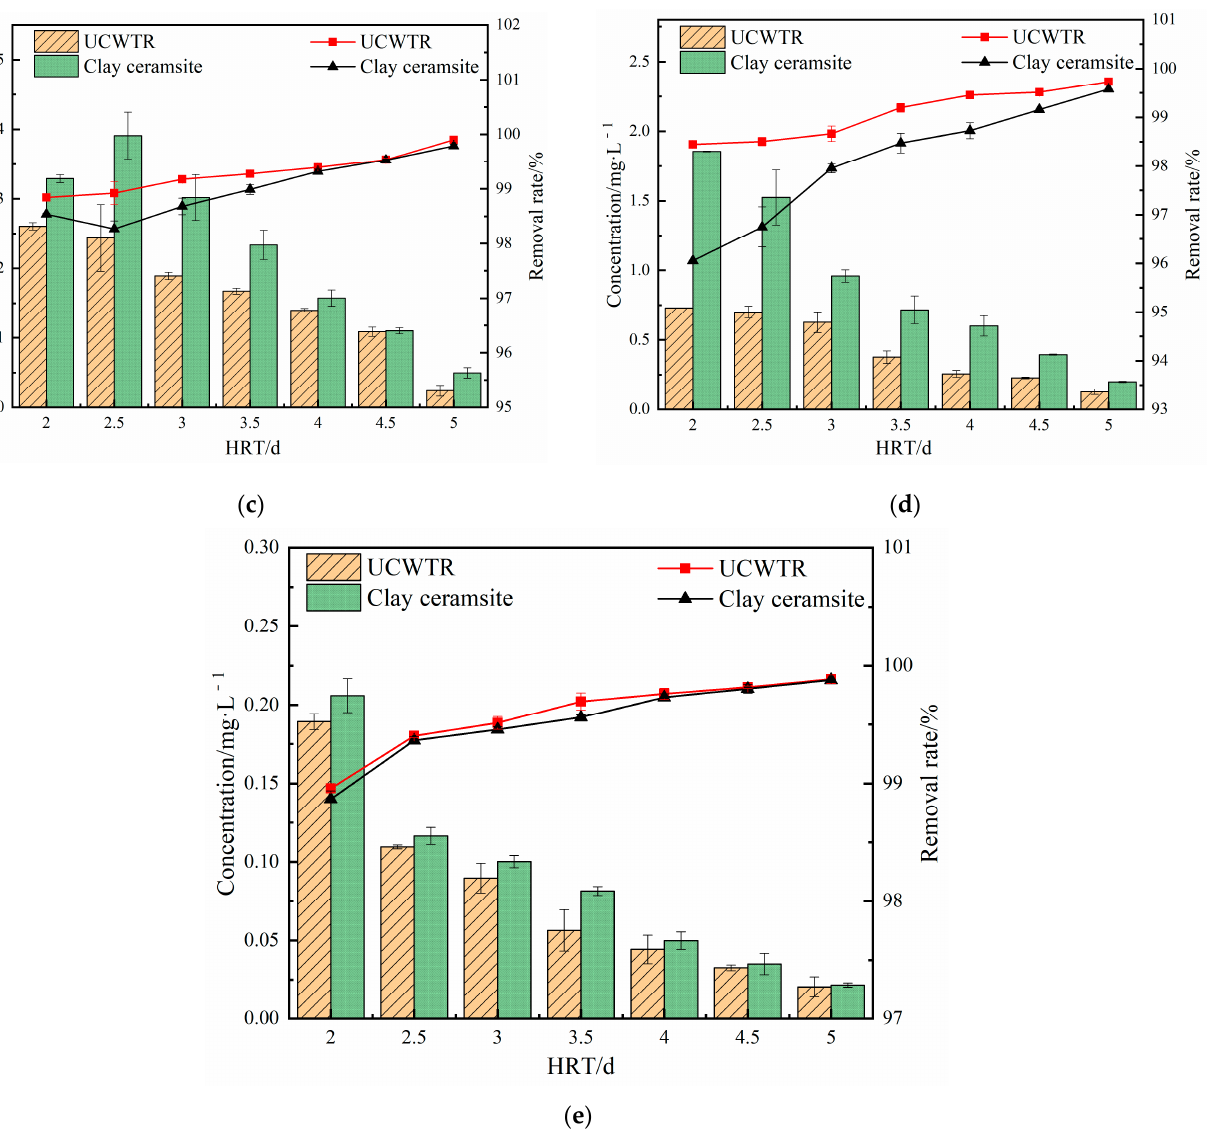
Figure 3. Changes of ( a ) Pb, ( b ) Cd, ( c ) Cu, ( d ) Zn, ( e ) Fe concentrations in effluent under different HRT.